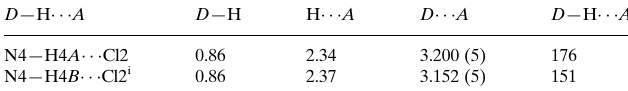
Hydrogen-bond geometry (A˚ , (cid:5) ). D —H (cid:2)(cid:2)(cid:2)